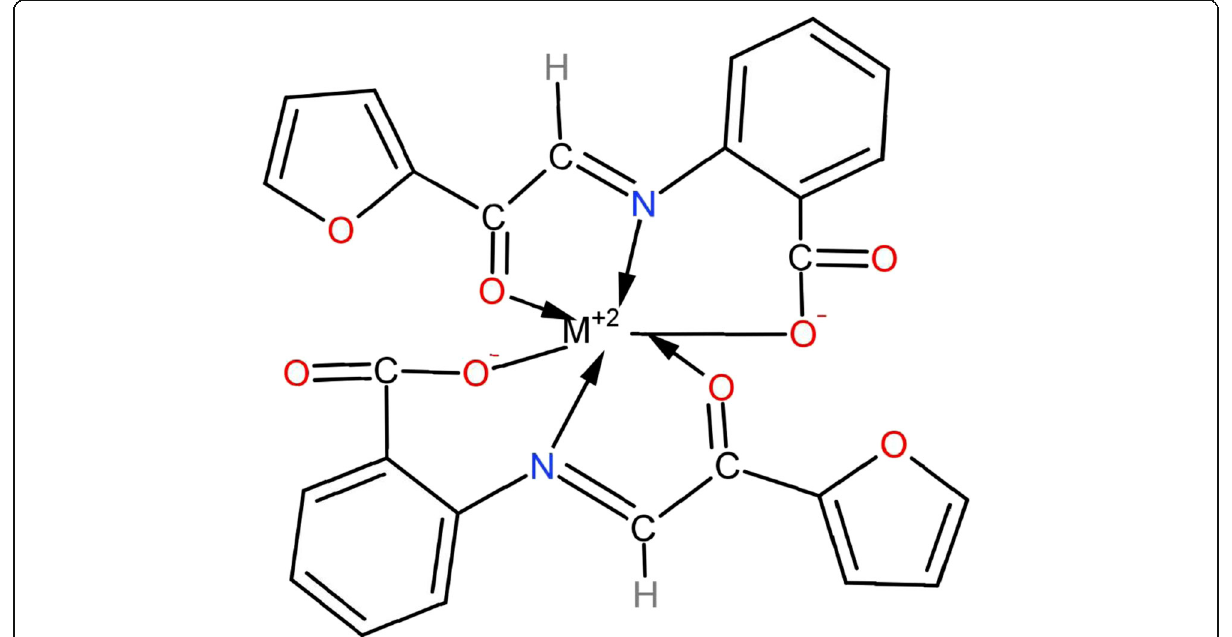
Fig. 1 The proposed structure of metal complex M = Cu(II) or Ni(II) or